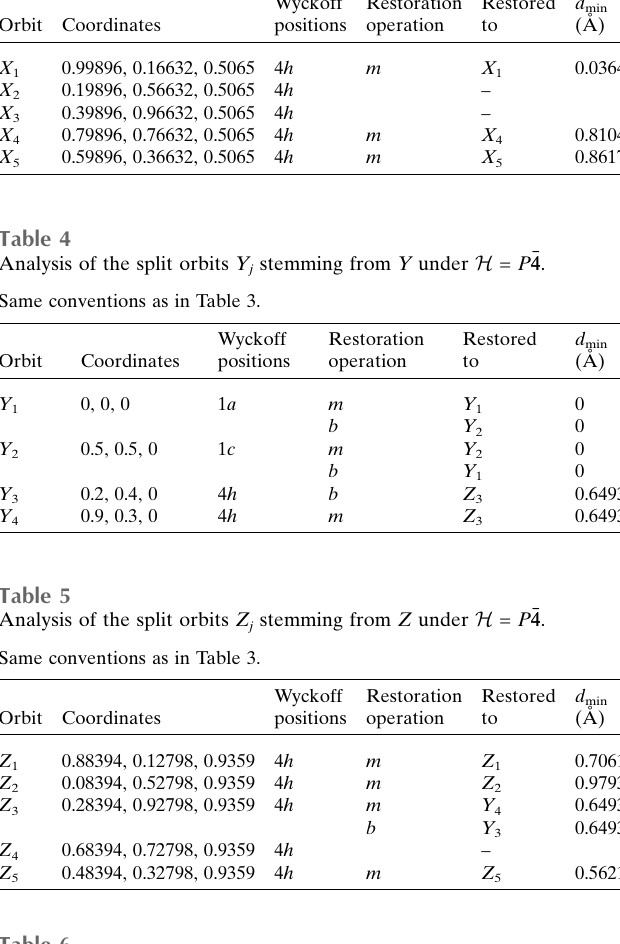
Table 6 Analysis of the split orbits O 1 j stemming from O 1 under H = P (cid:2) 44. Same conventions as in Table 3. The restorations with d min below 1 A˚ are highlighted in